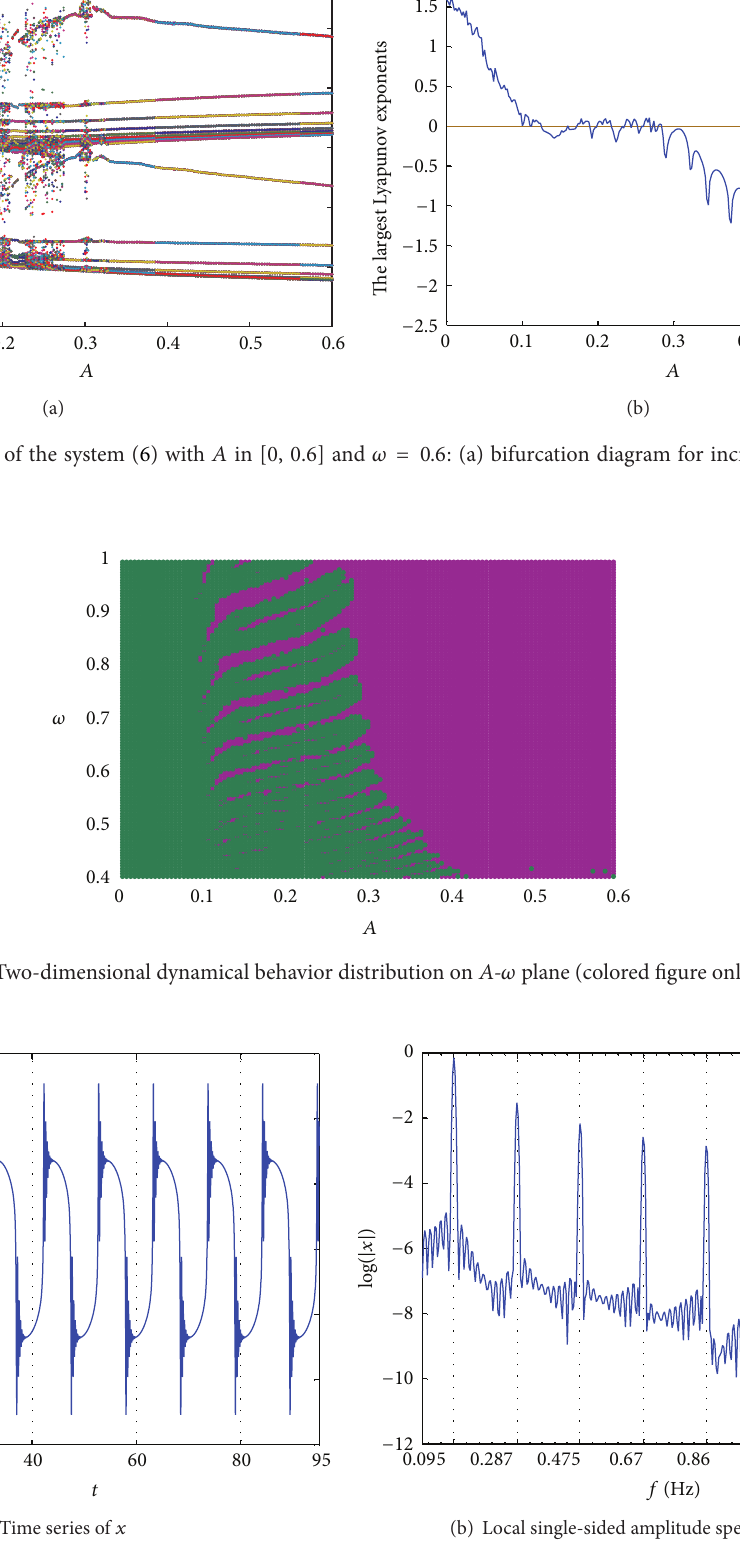
Figure 7: Time series and power spectrum of the system (6) with 𝐴 = 1 and 𝜔 = 0.6